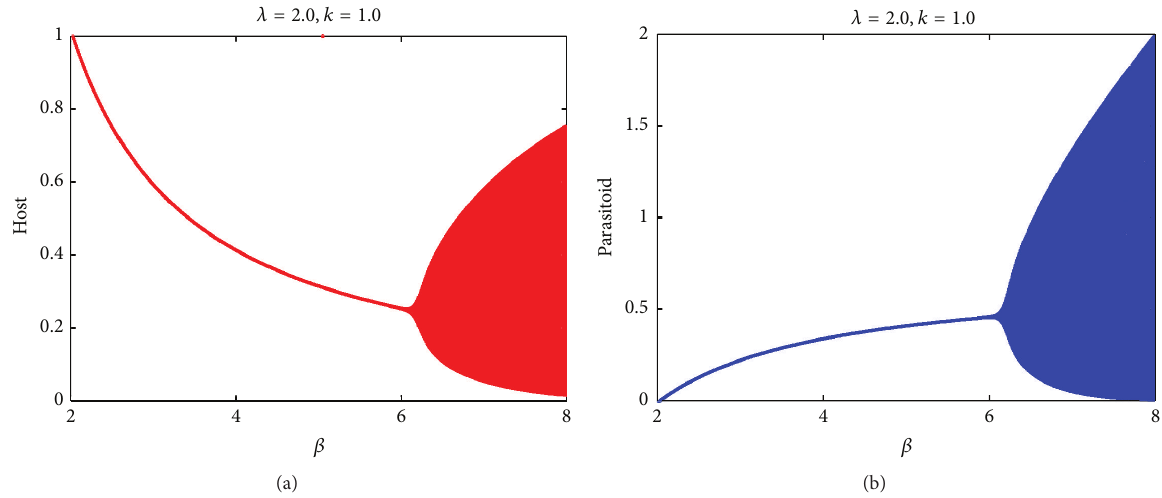
Figure 1: Bifurcation diagrams for system (4) with a Beverton-Holt growth rate. Parameter values are 𝜆 = 2 and 𝑘 =